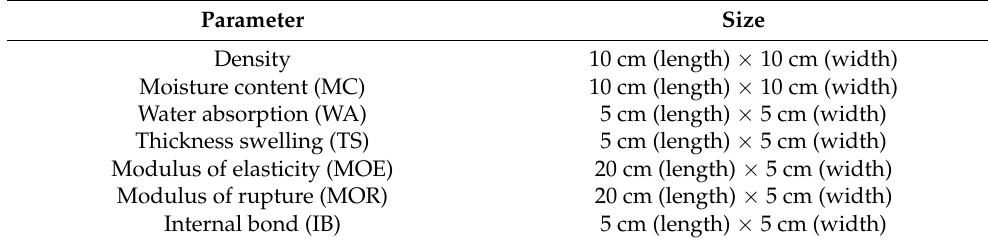
Table 4. Particleboard test sample sizes.